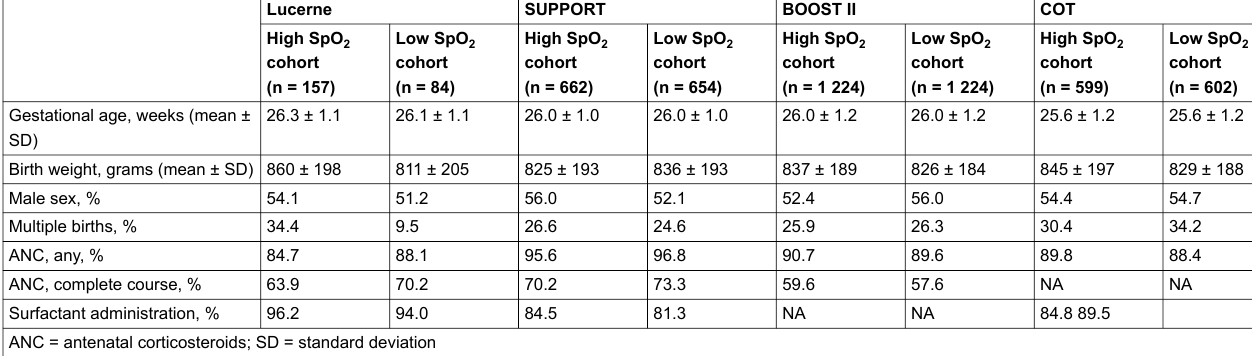
Table 3: Comparison of major outcomes from the current study and randomized controlled SpO 2 target trials.